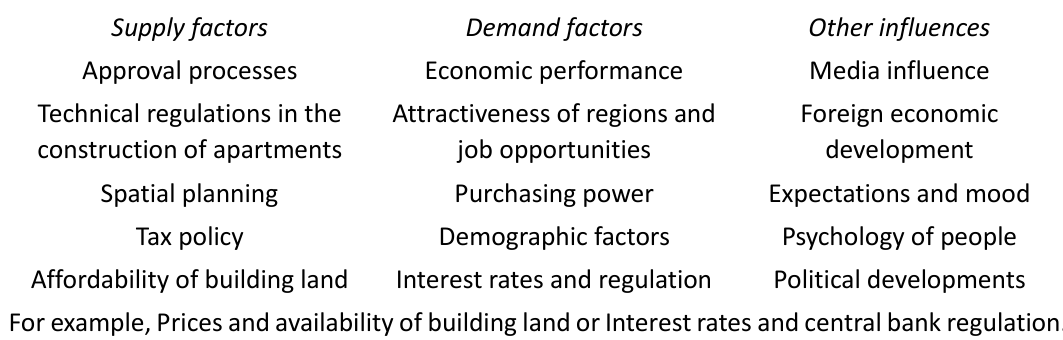
Table 1: Main factors affecting residential real estate prices (source: authors with use of